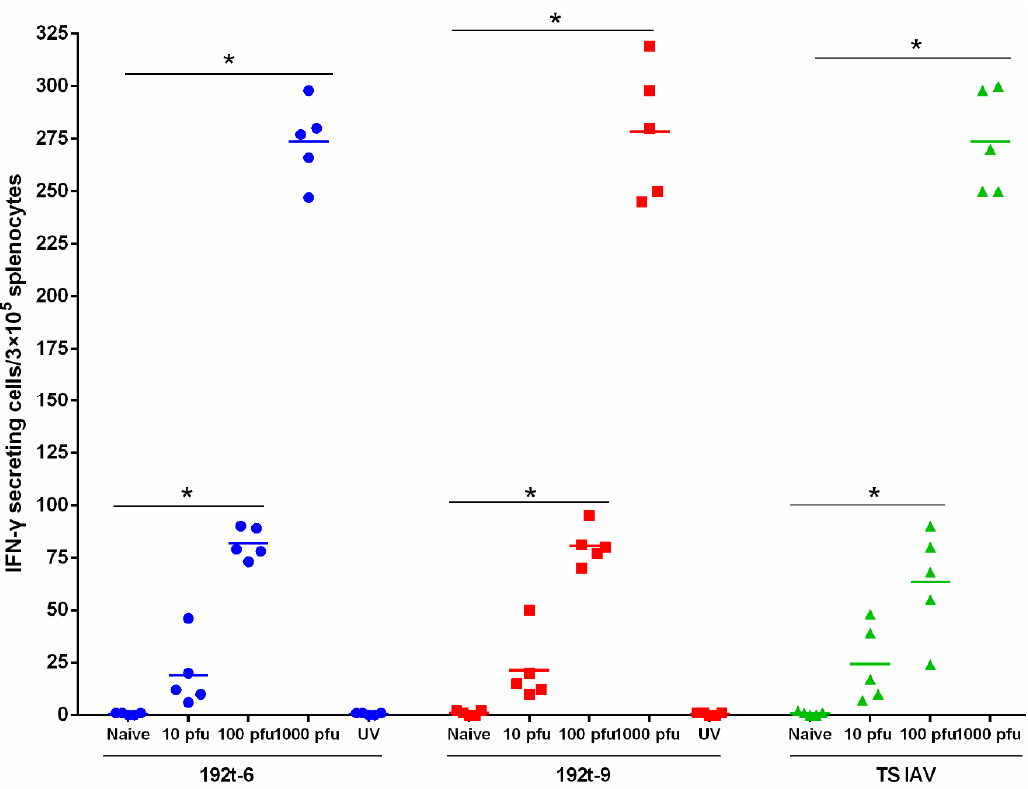
Figure 5. miRNA targeted viruses of 192t-6 and 192t-9 enhance cellular immune response. Mice were immunized i.n. once with various doses of 192t-6, 192t-9 and TS IAV which was as the positive control group, and naive, UV 192t-6 and UV 192t-9 which were as control groups ( n = 5 per group). The number of IFN- γ secreting splenocytes of immunized mice was measured by ELISpot assay four weeks after immunization. Data shown as mean numbers of spot-forming cells (SFCs). Each sample was tested in triplicates. * p < 0.05, compared to the naive